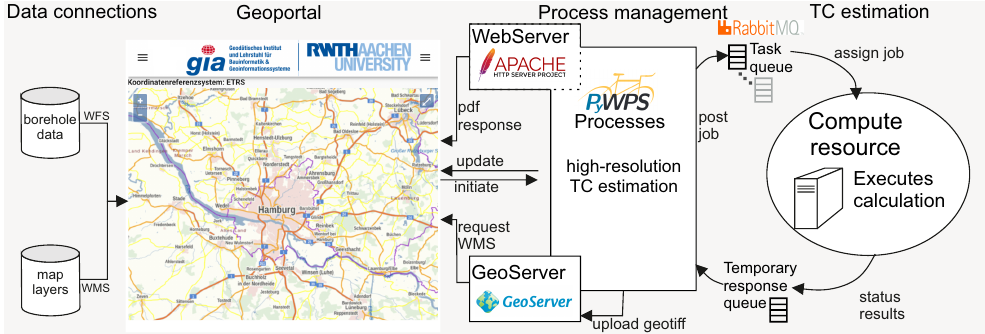
Figure 5. Overview of the web-based geodata infrastructure. Left: data connection to geodata servers, right: geodata infrastructure including asynchronous process